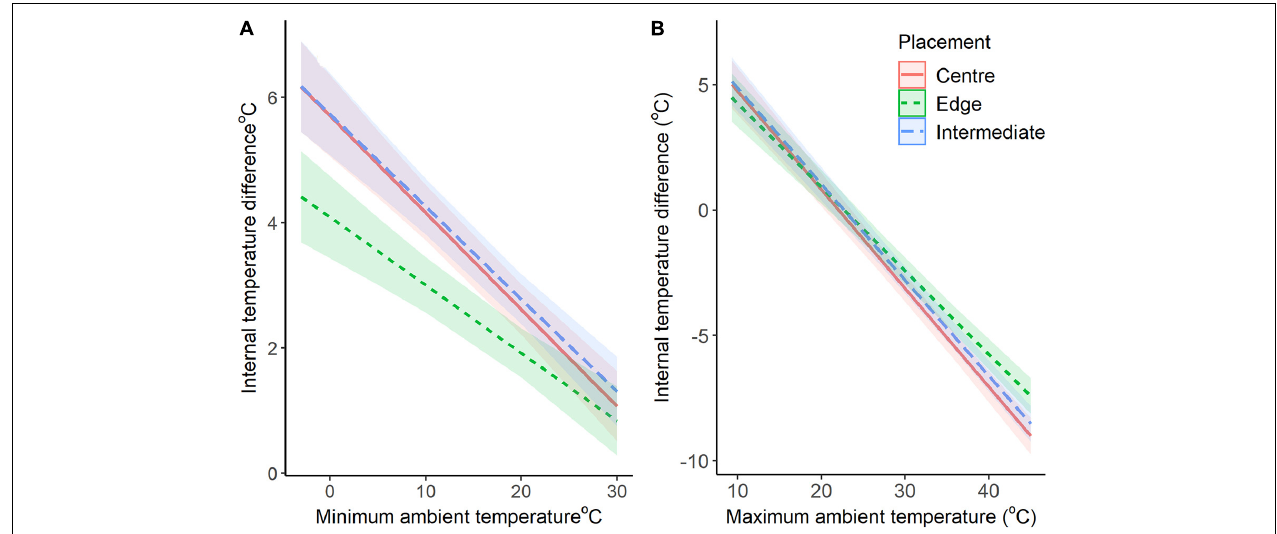
FIGURE 3 | Comparison of the buffering capabilities of nest chambers (+95% CI) against maximum (A) and minimum (B) ambient temperatures. The lines represent the difference between internal and ambient temperatures (model predicted values with 95% confidence intervals).